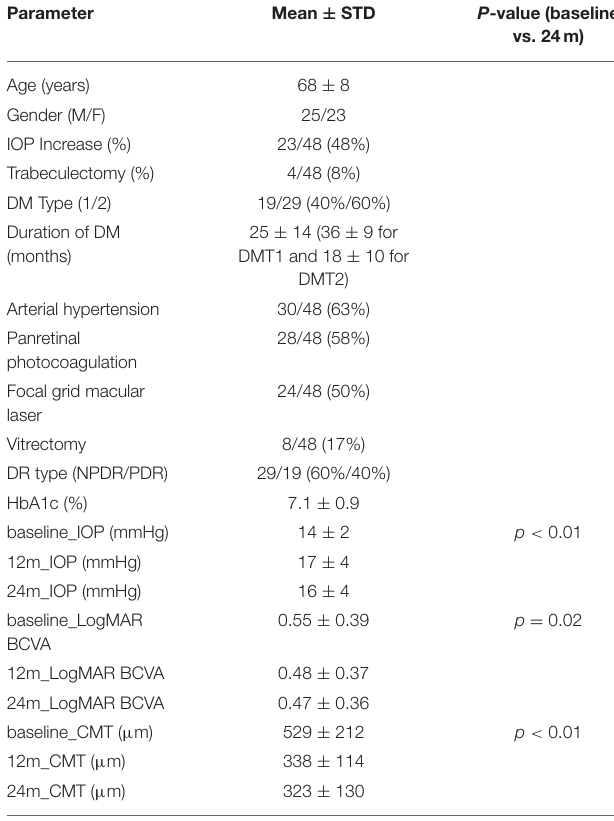
TABLE 1 | Clinical and Imaging